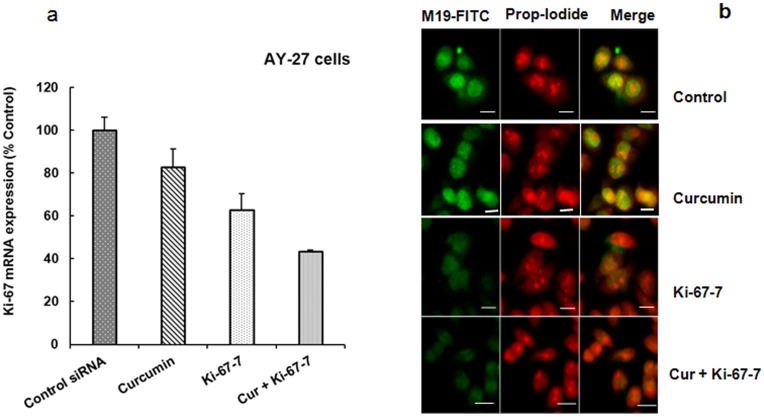
Effect of Ki-67-7 and curcumin on Ki-67 a) gene and b) protein expression in bladder cancer cells.a) AY-27 cells were treated with Ki-67 siRNA in the presence or absence of curcumin exactly as described in legend to Figures 3A and 3B. At the end of the treatment, RNA was extracted and Ki-67 mRNA expression was determined by quantitative PCR using β-actin as the internal standard as described in Methods. Ki-67 mRNA levels are expressed as percent of the rate of expression in control cells which were treated with transfection reagent and DMSO. Bars indicate values which are the mean ± S.E of three determinations. b) AY-27 cells were grown on glass coverslips placed inside 12-well plates and treated with siRNA (Ki-67-7), curcumin or as a combination, as described in the legend to Figures 3A and 3B. At the end of the treatment period, cells were exposed to Ki67 primary antibody (M19) and FITC-labeled secondary antibody followed by PI (Propidium iodide), and observed under confocal microscopy as described in Methods. Scale bar inserts  = 5 µm. Increased down-regulation of Ki-67 protein due to Ki-67-7 was observed.